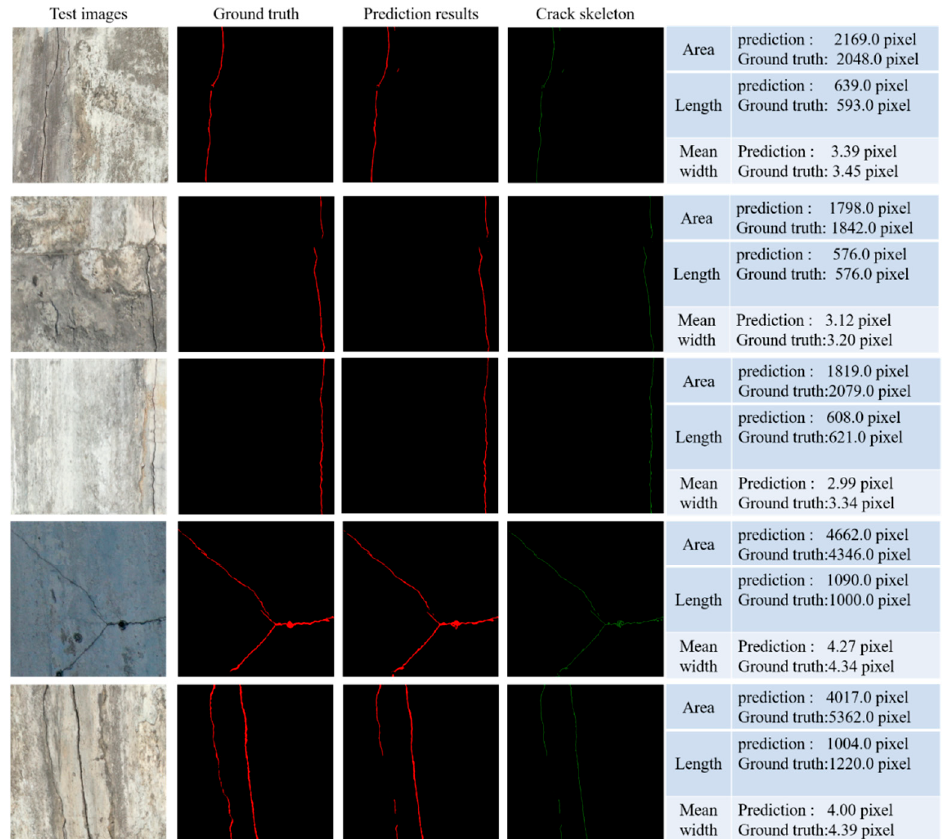
Figure 13. Examples of crack skeleton extraction and size calculation.